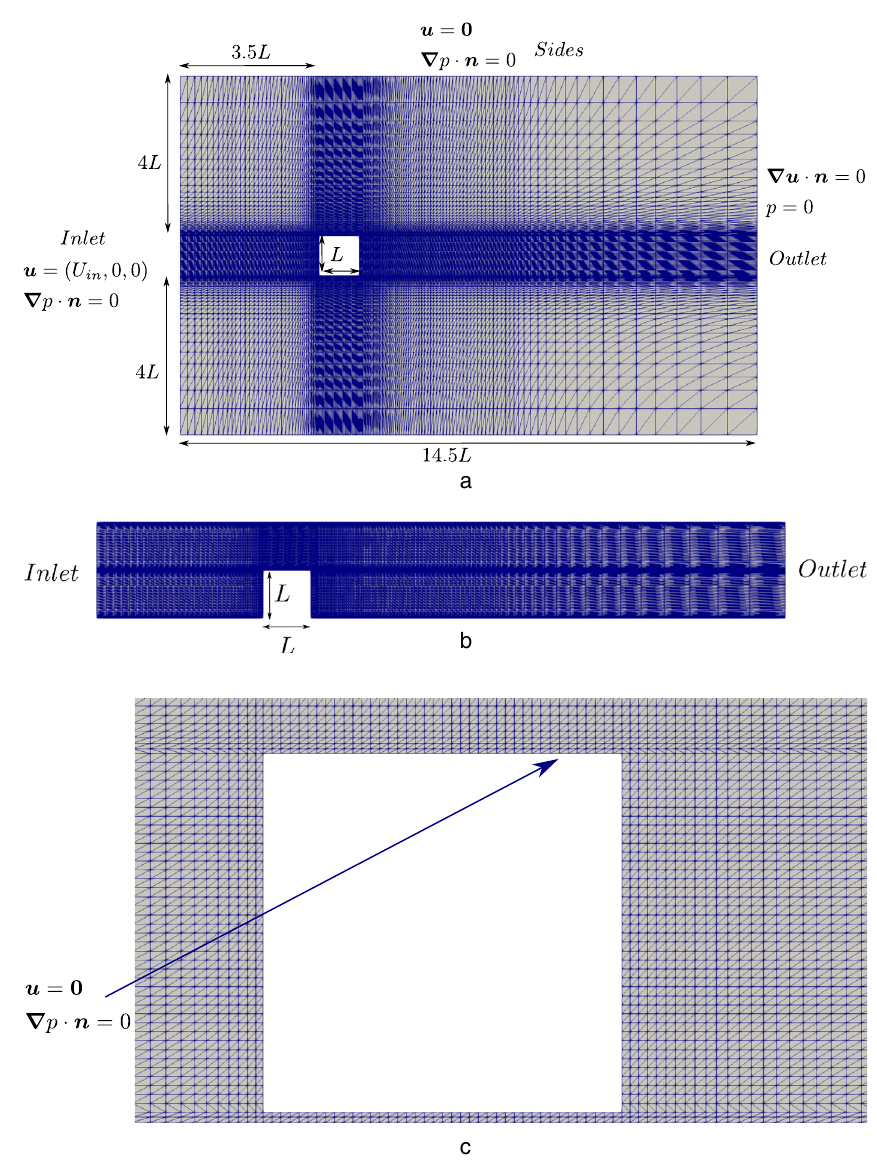
Fig. 10 The OpenFOAM mesh used in the simulations for the case of the flow around a surface mounted cube. (a) A cross-sectional view of the grid at x 3 = L , the boundary conditions for the velocity and pressure are reported for the inlet, outlet and the sides. (b) A cross-sectional view of the grid at x 3 = 4.5 L . (c) A zoomed picture near the box with boundary conditions imposed on